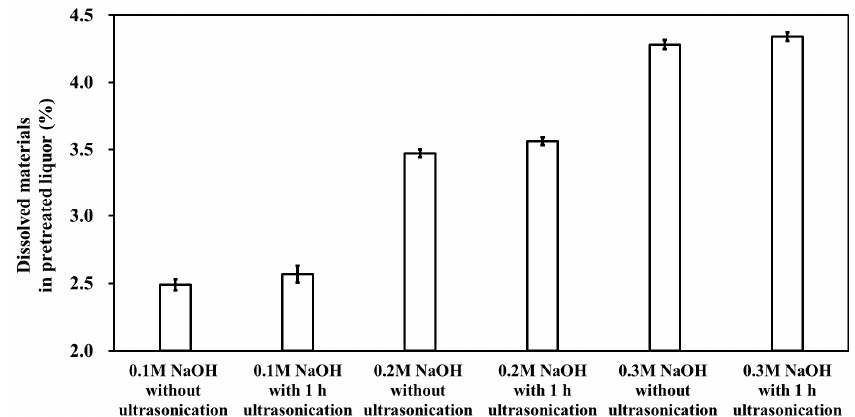
Figure 2. Dissolved materials in the pretreated liquor of M. sacchariflorus G1.